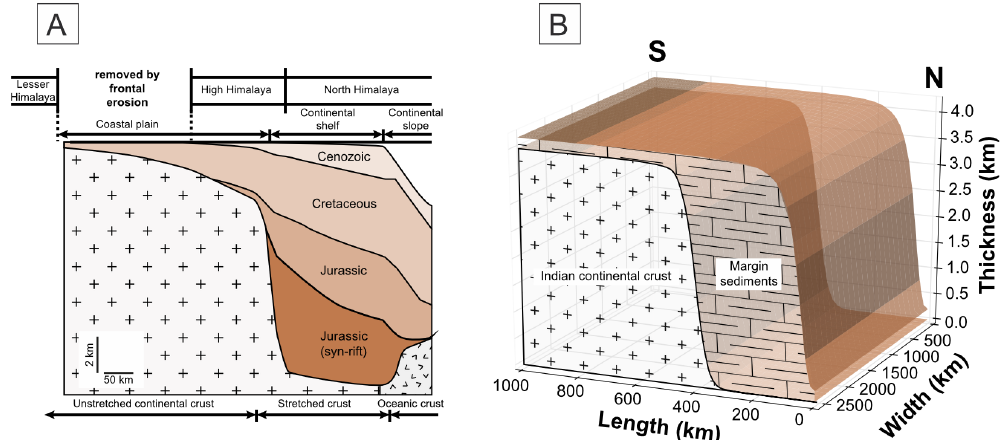
Figure 2. (a) Geometry of the Eastern US Atlantic coastal margin showing analogous positions for tectonic units of Indian passive margin (modified from Brookfield, 1993). (b) Geometry of Indian margin used in Carbonate Subduction Factory Model